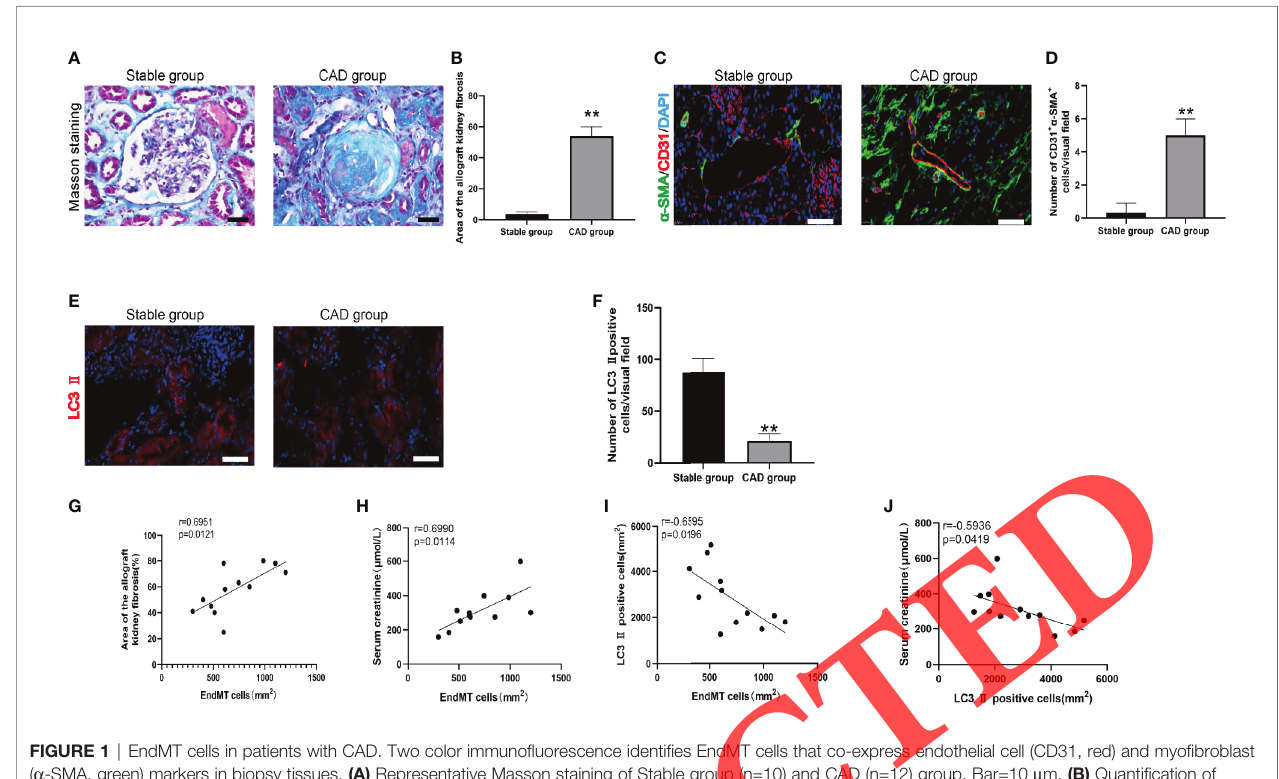
FIGURE 1 | EndMT cells in patients with CAD. Two color immuno fl uorescence identi fi es EndMT cells that co-express endothelial cell (CD31, red) and myo fi broblast ( a -SMA, green) markers in biopsy tissues. (A) Representative Masson staining of Stable group (n=10) and CAD (n=12) group. Bar=10 m m. (B) Quanti fi cation of fi brosis areas in Stable group and CAD group. (C) Representative immuno fl uorescence staining of EndMT cells in Stable group and CAD group. Bar=20 m m. (D) Quanti fi cation of CD31 and a -SMA co-express cells. LC3 II positive cells in patients with CAD. (E) Representative immuno fl uorescence staining of LC3 II positive cells in Stable group and CAD group. Bar=20 m m. (F) Quanti fi cation of LC3 II positive cells. Data are mean ± SD. ** P <0.01 versus Stable group. (G) Correlation analysis of EndMT cells number and area of allograft fi brosis. (H) Correlation analysis of number of EndMT cells and allograft function. (I) Correlation analysis of numbers of EndMT cells and LC3 II positive cells. (J) Correlation analysis of number of LC3 II positive cells and allograft